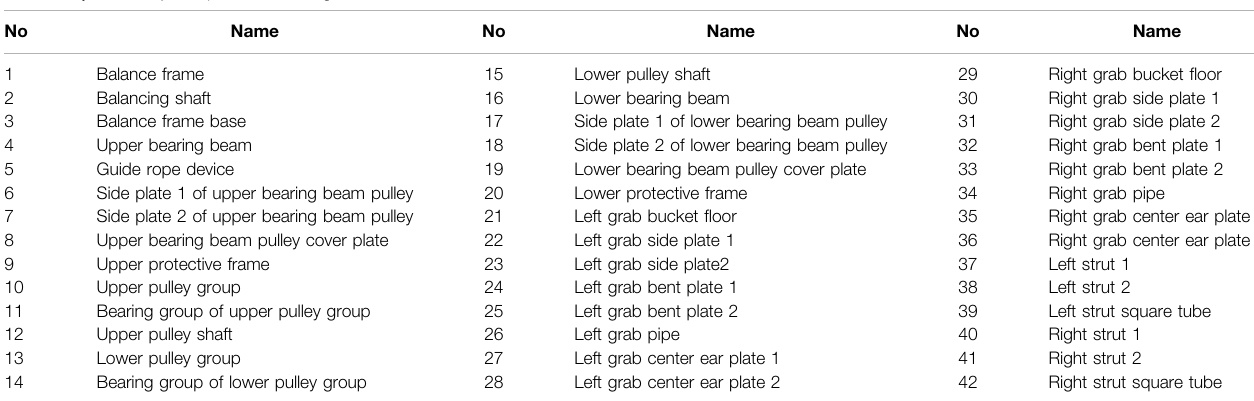
TABLE 3 | List of key components of the grab.